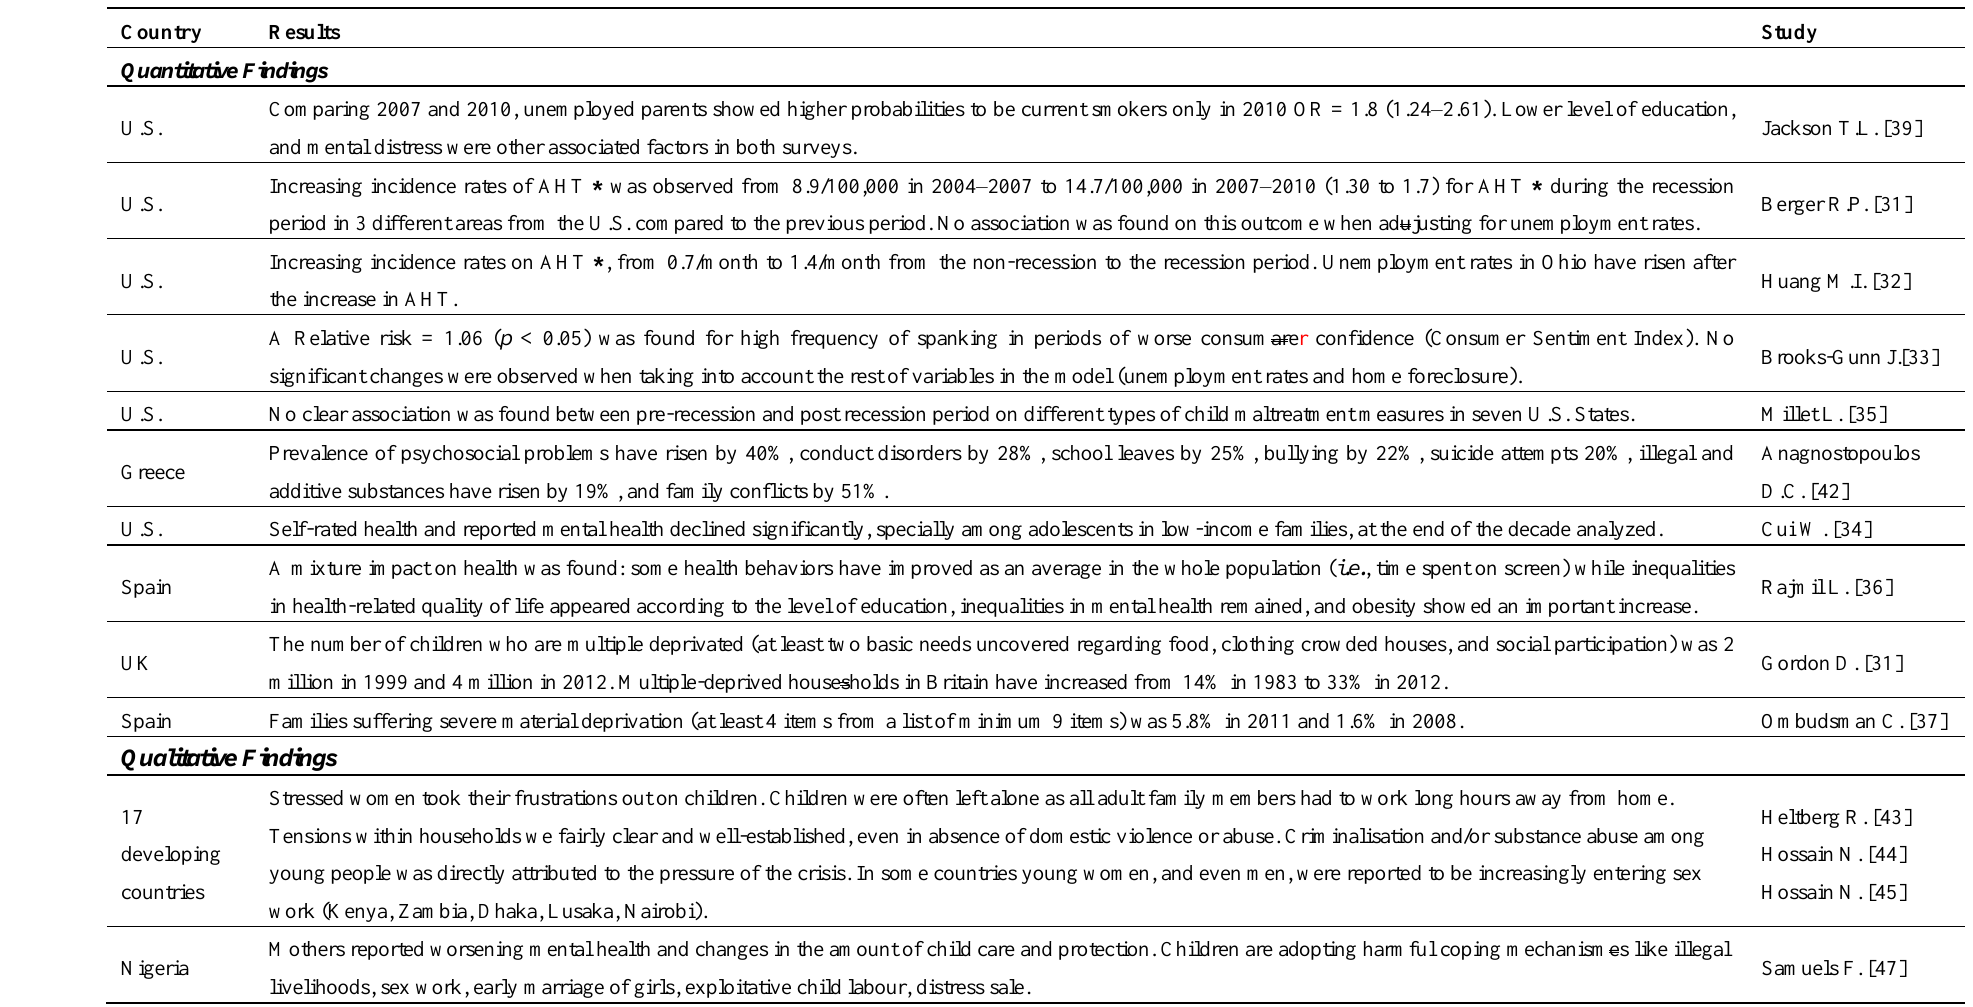
Table 4. Summary of the impact of the 2008 economic crisis on health behaviors, non-accidental injuries, mental health and health-related quality of life. Country Results Study Quantitative